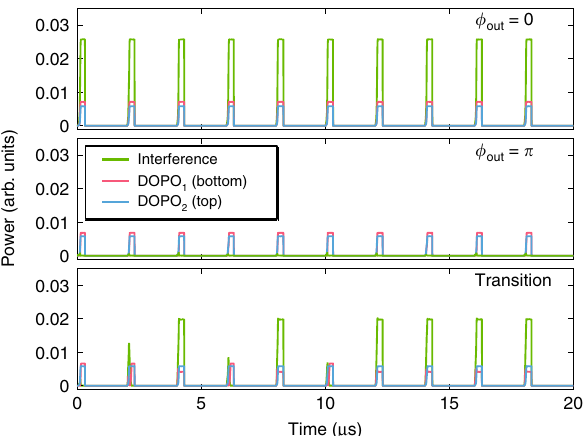
Fig. 5 Numerical modeling of coupled DOPO system. Simulated temporal interference between two DOPOs with unidirectional coupling. The plot shows the combined DOPO (green) and the individual DOPOs, DOPO 1 (red) and DOPO 2 (blue) for coupling phase ϕ c of 0° (in-phase, ϕ out = 0), 180° (out-of-phase, ϕ out = π ), and 90° (transition from in-phase to out-of- phase) from top to bottom.